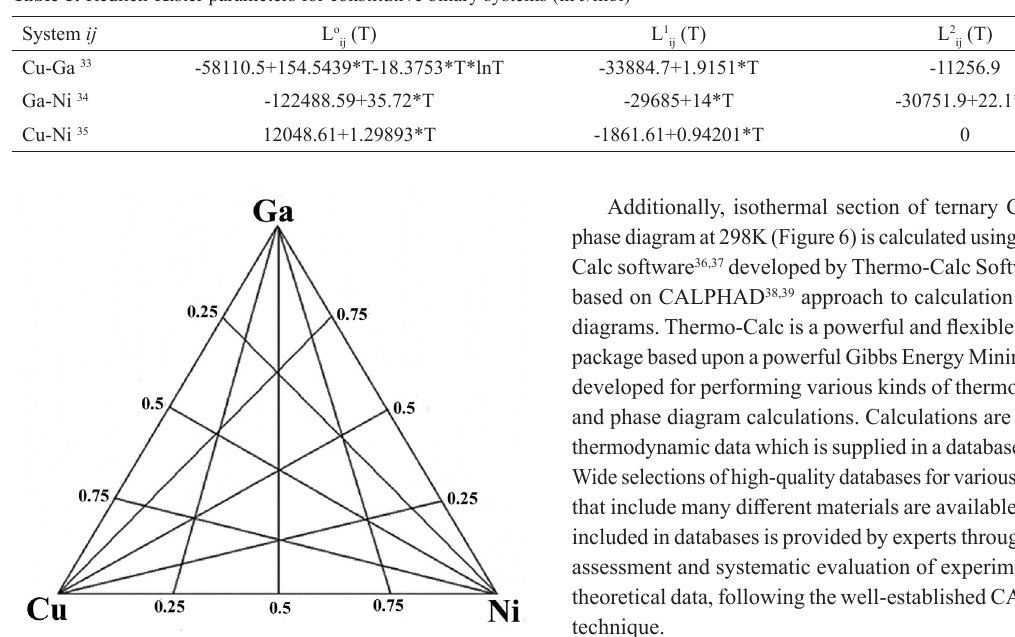
Figure 1: Schematic diagram of the investigated concentration regions in ternary Cu-Ga-Ni system.